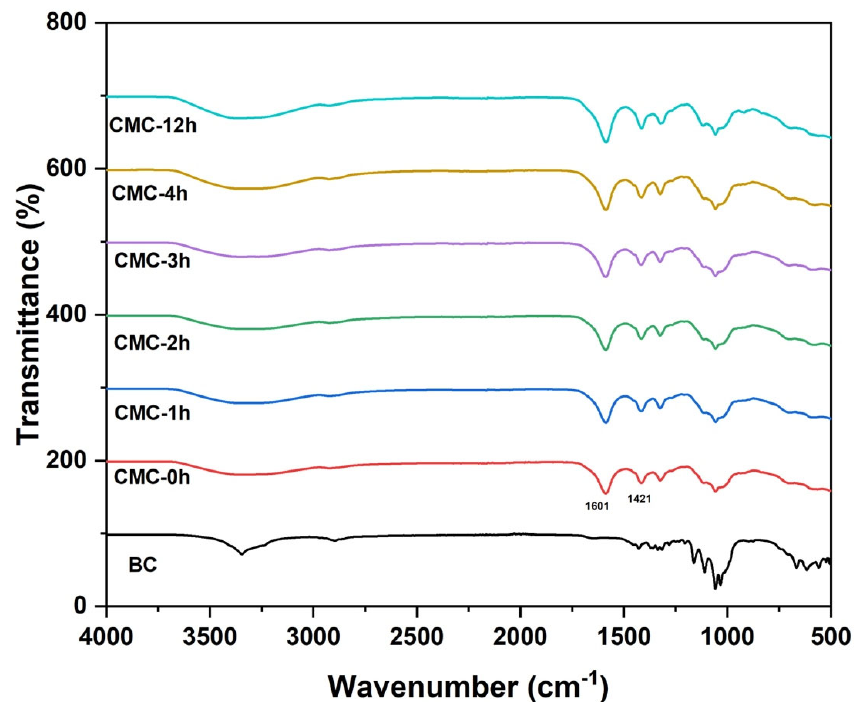
Figure 2. FTIR spectra of BC and CMC samples.